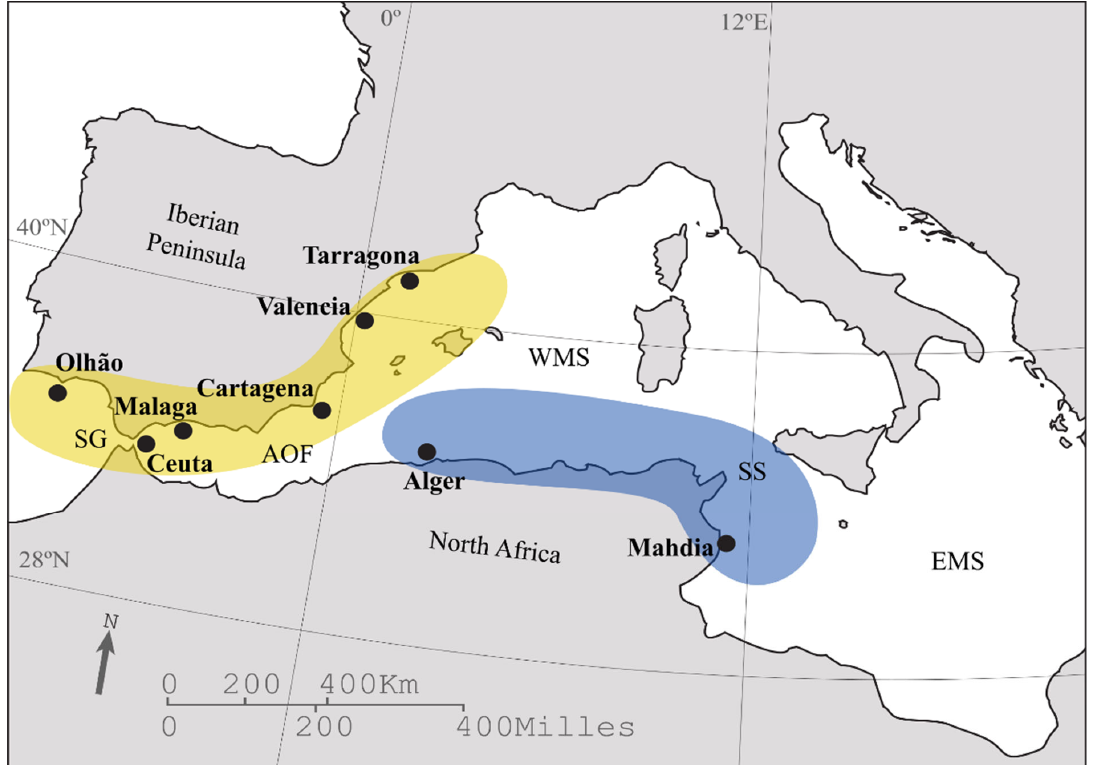
Figure 1. Geographical sampling of the bullet tuna included in the present paper. Black dots indicate sampling locations. Olhão, Ceuta, Málaga, Cartagena, Valencia, Tarragona, Alger, Mahdia. Main geographic areas are indicated as follows: Strait of Gibraltar (SG) coinciding with Ceuta location, Almeria Oran Front (AOF), Strait of Sicily (SS), western Mediterranean Sea (WMS) and eastern Mediterranean Sea (EMS). Colour pattern indicates the genetically identified stocks according to both mtDNA and microsatellite loci (see Discussion section).